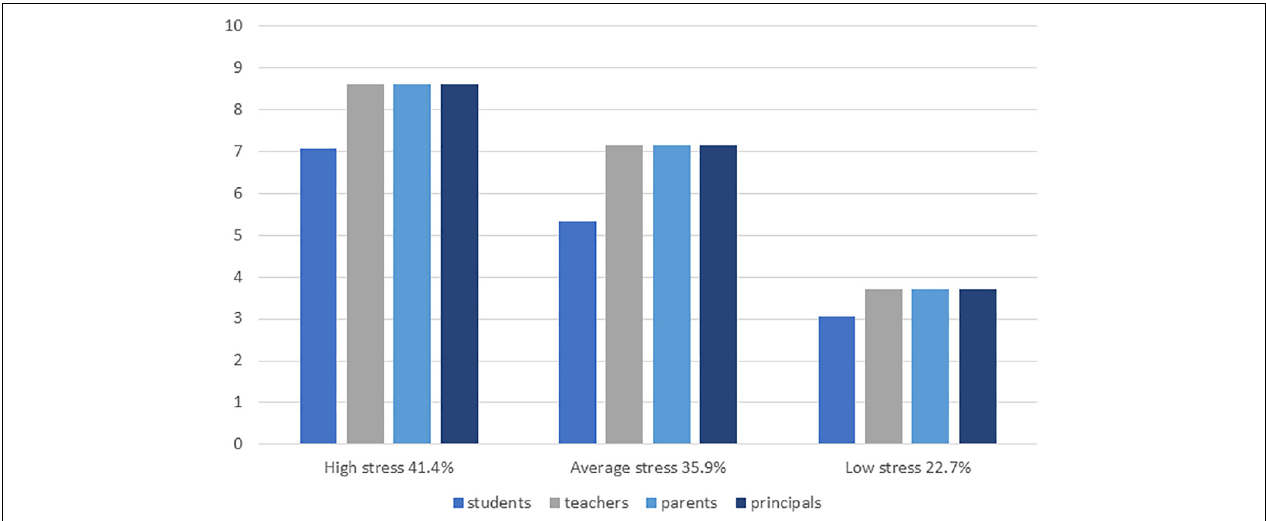
FIGURE 2 | Latent profiles of school principals’ stress concerning students’, teachers’, parents’, and principals’ ability to cope during the COVID-19